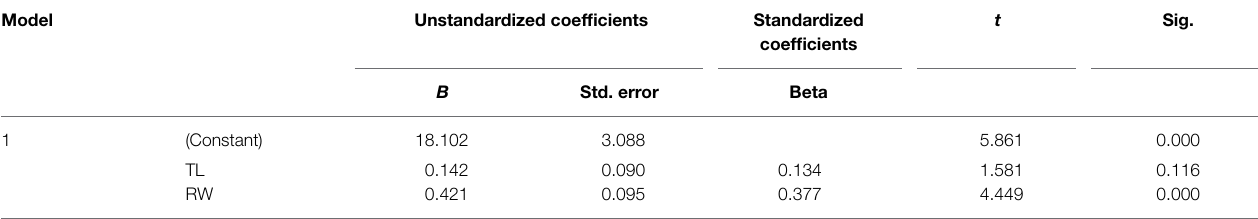
TABLE 8 | Partial regression coefficient test ( t -test) result.